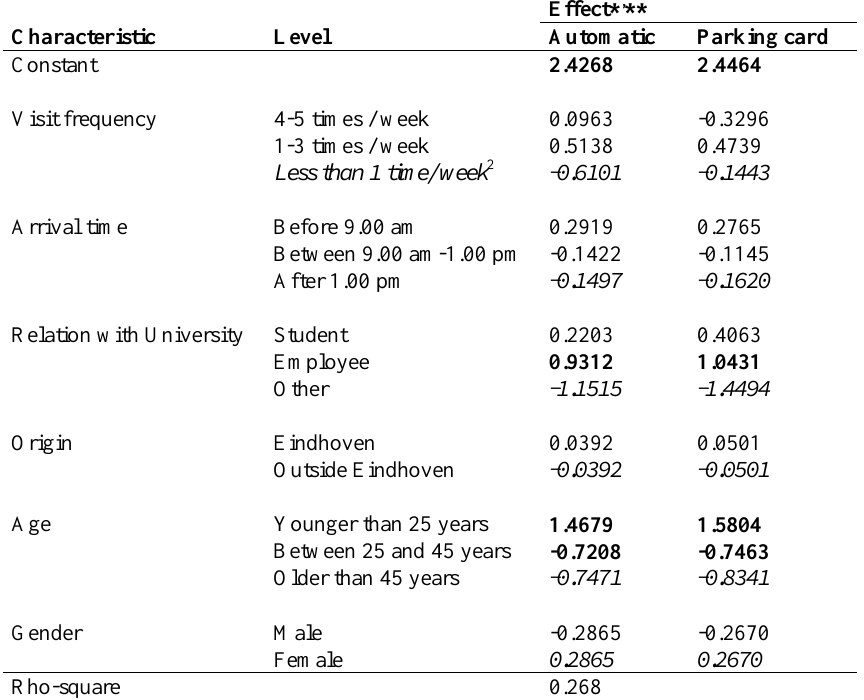
Table 6. Effects of personal characteristics on preferences for alternative means of